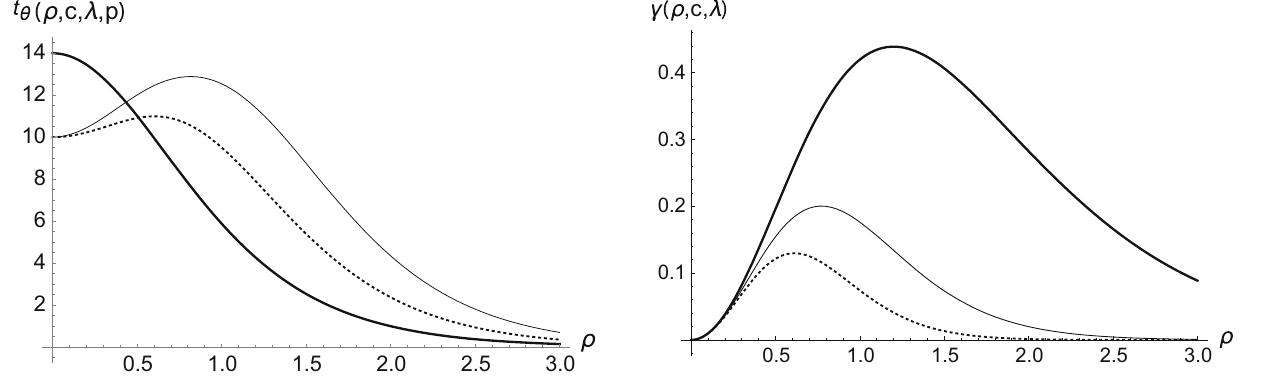
Fig. 2 Angular pressure for p = 1 (thick line), p = 3 (thin line) and p = 6 (dotted line)